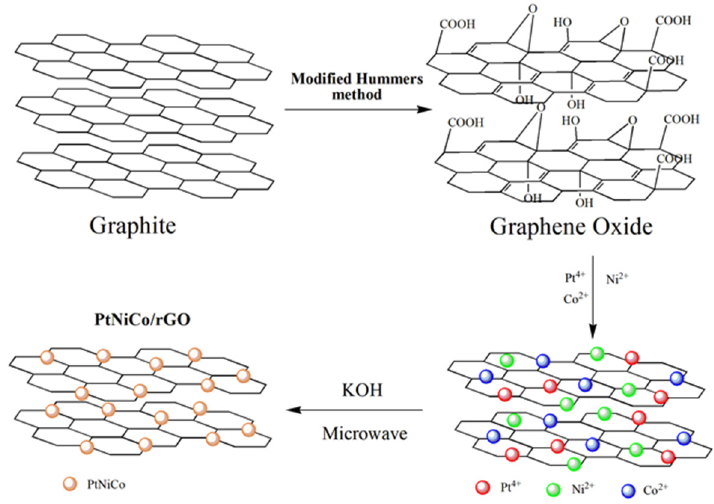
Figure 1. Illustration of the formation of the PtNiCo/rGO.